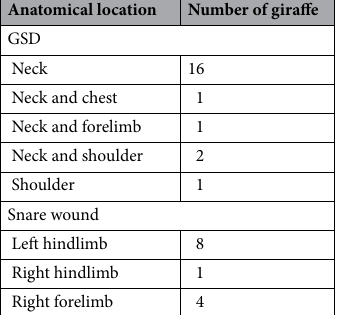
Table 3. Anatomical location of GSD and snare wounds in free-ranging Nubian giraffe Giraffa camelopardalis camelopardalis sample from Murchison Falls National Park, Uganda.